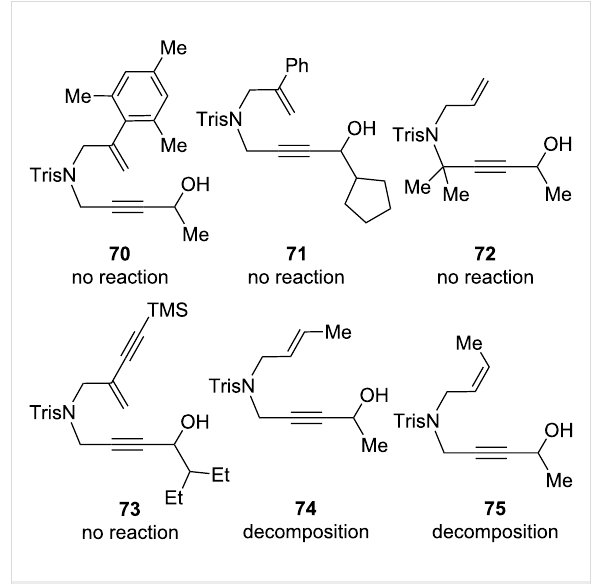
Figure 3: Failed bicycloisomerization substrates. Reactions per- formed at 40 °C for 16 hours with 3 mol % of catalyst 1 in acetone at a 0.25 M concentration relative to